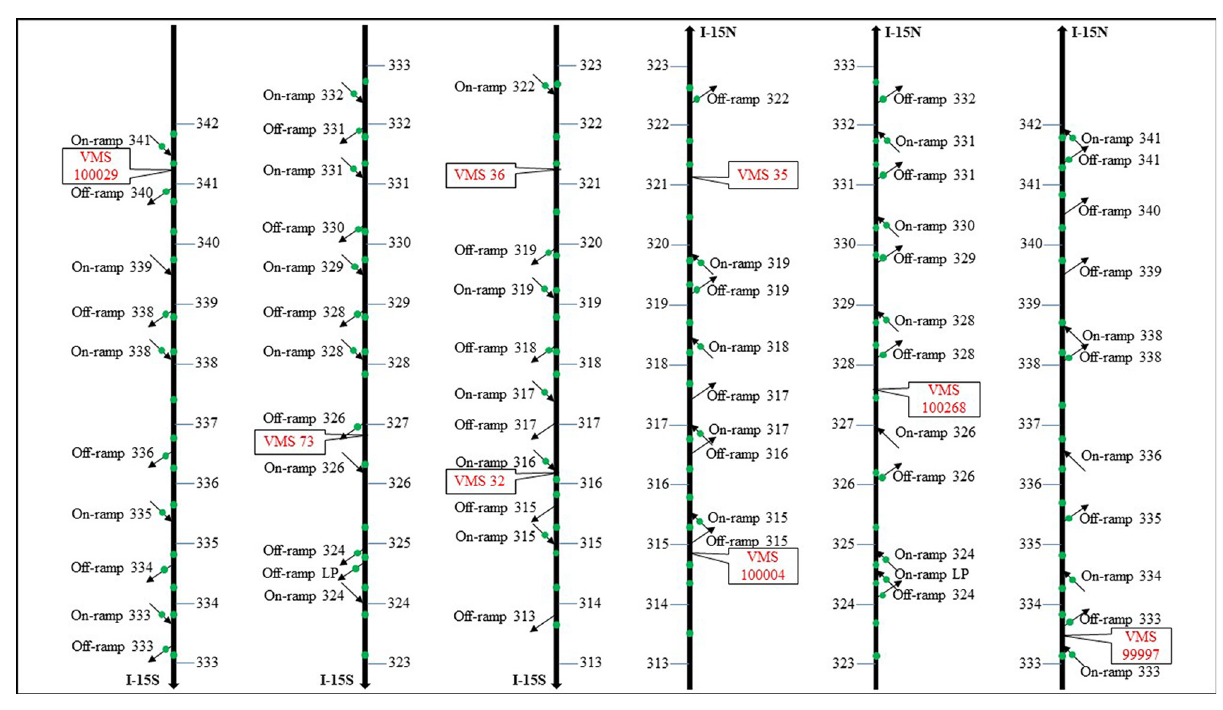
Figure 1 Study site (I-15 between Mileposts 313 and